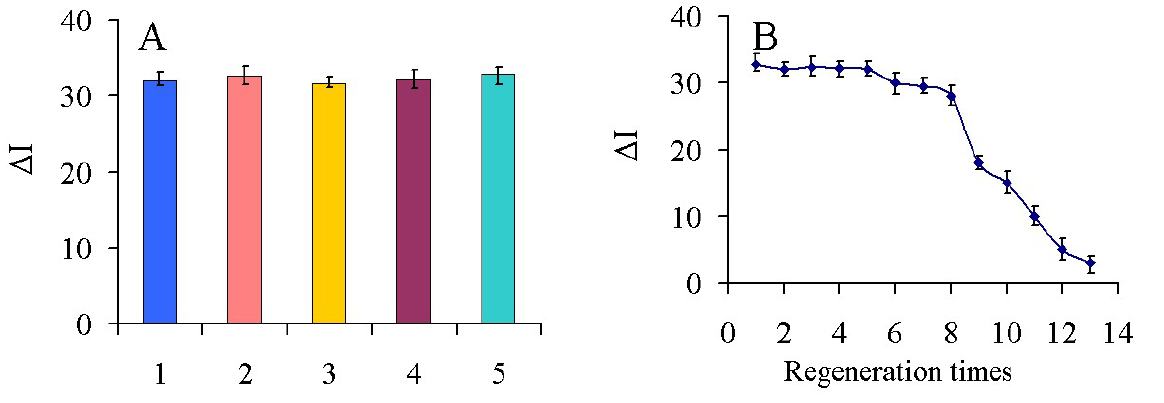
Figure 7. ( A ) The Δ I of proposed immunosensor to: (1) 100 ng/mL carbofuran, (2) 100 ng/mL carbofuran+100 ng/mL chlorpyrifos, (3) 100 ng/mL carbofuran+100 ng/mL